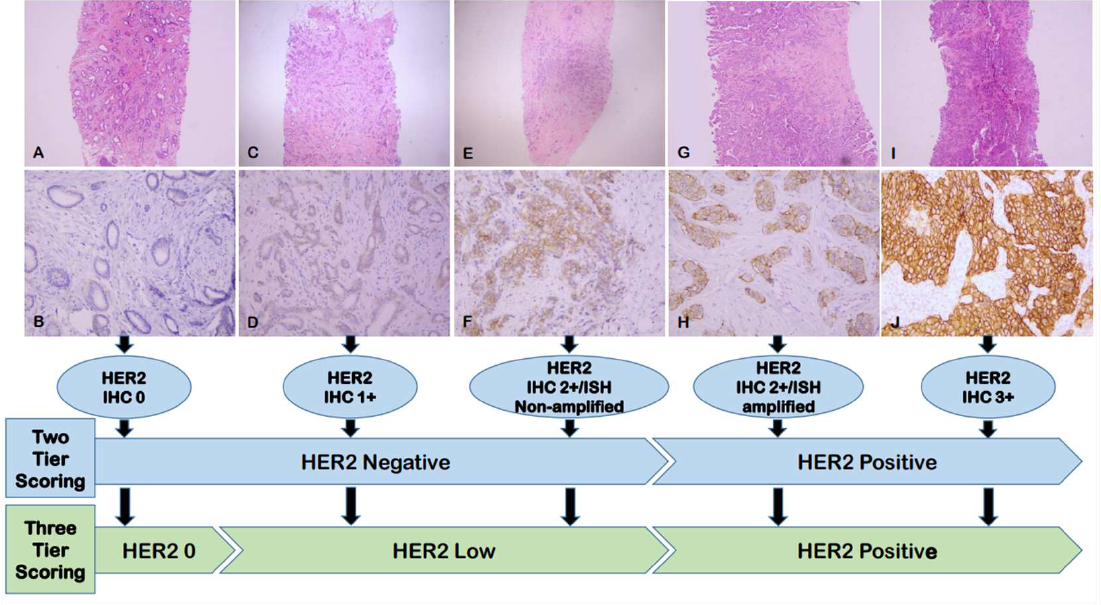
Figure 1. The changes of HER2 scoring in BC from the current two-tier to three-tier scoring system with the addition of HER2-low category. ( A , C , E , G , I ): Hematoxylin & eosin staining of breast cancer, ×40; ( B , D , F , H , J ): Corresponding HER2 IHC, ×200. Abbreviations: HER2: Human epidermal growth factor receptor 2; IHC: Immunohistochemistry; ISH: In situ hybridization.